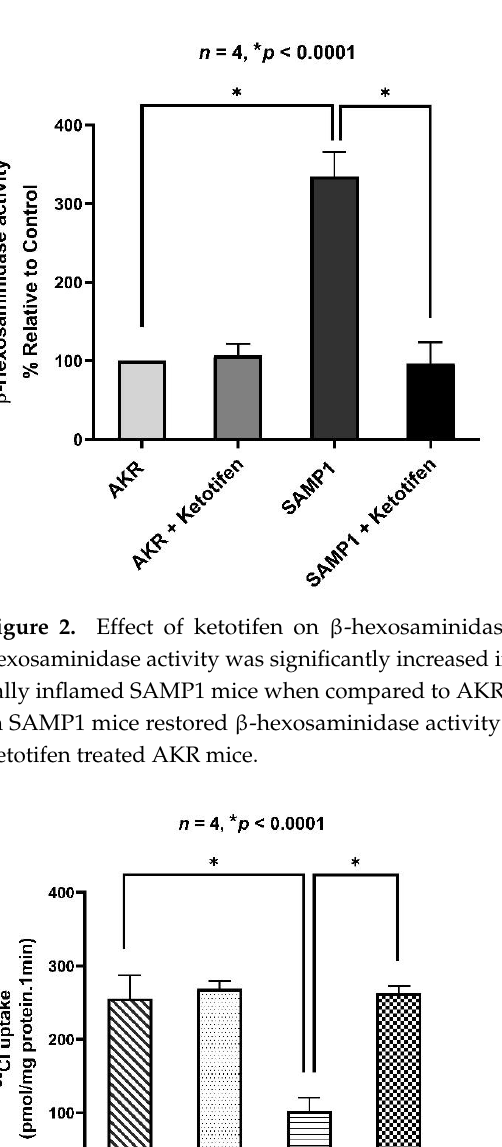
Figure 4. Na/H exchanger (NHE3) activity in ileal villus cells BBMV. pH dependent and amiloride sensitive 22 Na uptake was measured as NHE3 activity, which remained unchanged in BBMVs of intestinal villus cells from SAMP1 mice compared with AKR control mice. 3.5. Kinetic Studies for Cl − /HCO 3− Exchange To determine the mechanisms of reversal of the Cl − /HCO 3− exchange activity by ke- totifen in inflamed villus cells, we performed intact villus cell kinetic studies. Figure 5 shows 36 Cl uptake in intact villus cell as a function of varying concentrations of extra- vesicular Cl. As the concentration of extra-vesicular Cl was increased, 36 Cl uptake was stimulated and subsequently became saturated in all conditions. Kinetic parameters demonstrated that in the intact intestinal villus cells isolated from SAMP1 mice inhibition of Cl − /HCO 3− exchange activity occurs as a result of an increase in the K m , and in vivo ketotifen treatment reversed this change (K m was 11.14 ± 0.5 mM in AKR, 19.44 ± 0.3 mM in SAMP1, 11.01 ± 0.3 mM in SAMP1 + Ketotifen; n = 4). The maximal rate of uptake (V max ) was unaffected in all conditions (V max was 1.62 ± 0.04 nmol/mg protein/30 s in AKR, 1.75 ± 0.03 in SAMP1, 1.65 ± 0.05 in SAMP1 + Ketotifen; n = 4). These data indicate that the mechanism of reversal of inhibition of Cl − /HCO 3− exchange by ketotifen during chronic